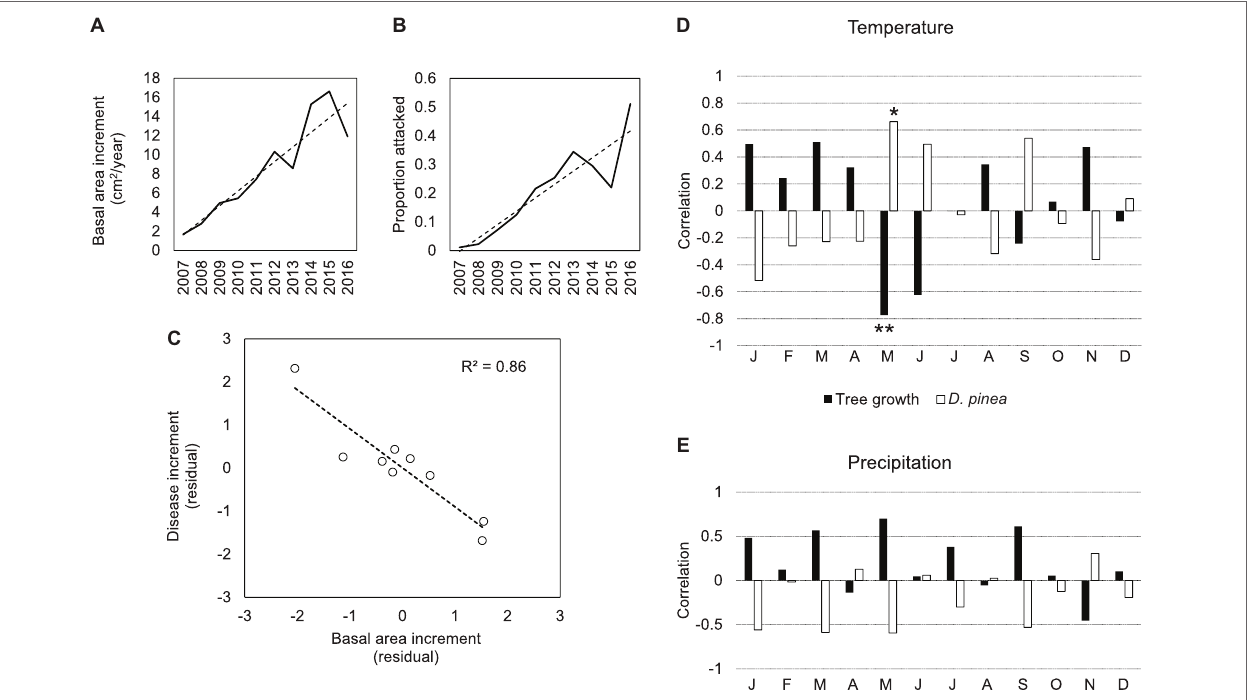
FIGURE 4 | Temporal association between tree growth, D. sapinea epidemic, and weather conditions. (A) Tree radial growth based on basal area increments (BAI) and development of D. sapinea in the stand from 2007 to 2016 ( n = 264 trees) (B) , correlation between standardized residuals from D. sapinea increments and BAI of 264 trees over 9 years (C) , correlation between average monthly temperatures (D) and precipitation (E) from 2007 to 2016 ( n = 9 years) and standardized residuals from D. sapinea increments and BAI from 264 trees. Dashed lines in a, b, and c show adjusted linear regression. Significance levels in bar plots: ** p < 0.01; * p <